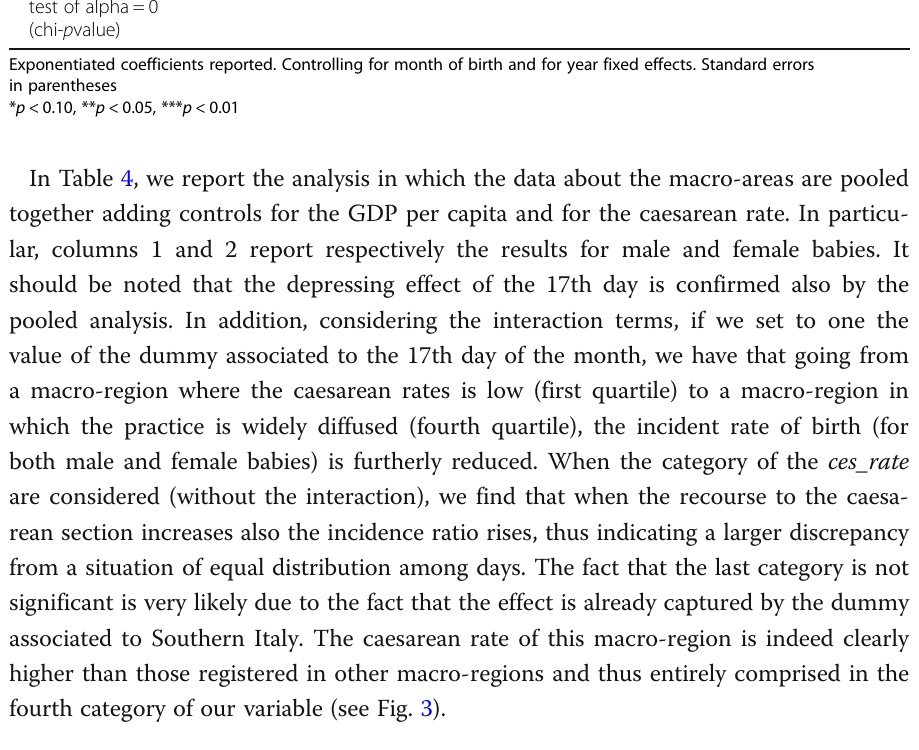
Exponentiated coefficients reported. Controlling for month of birth and for year fixed effects. Standard errors in parentheses * p <0.10, ** p <0.05, *** p